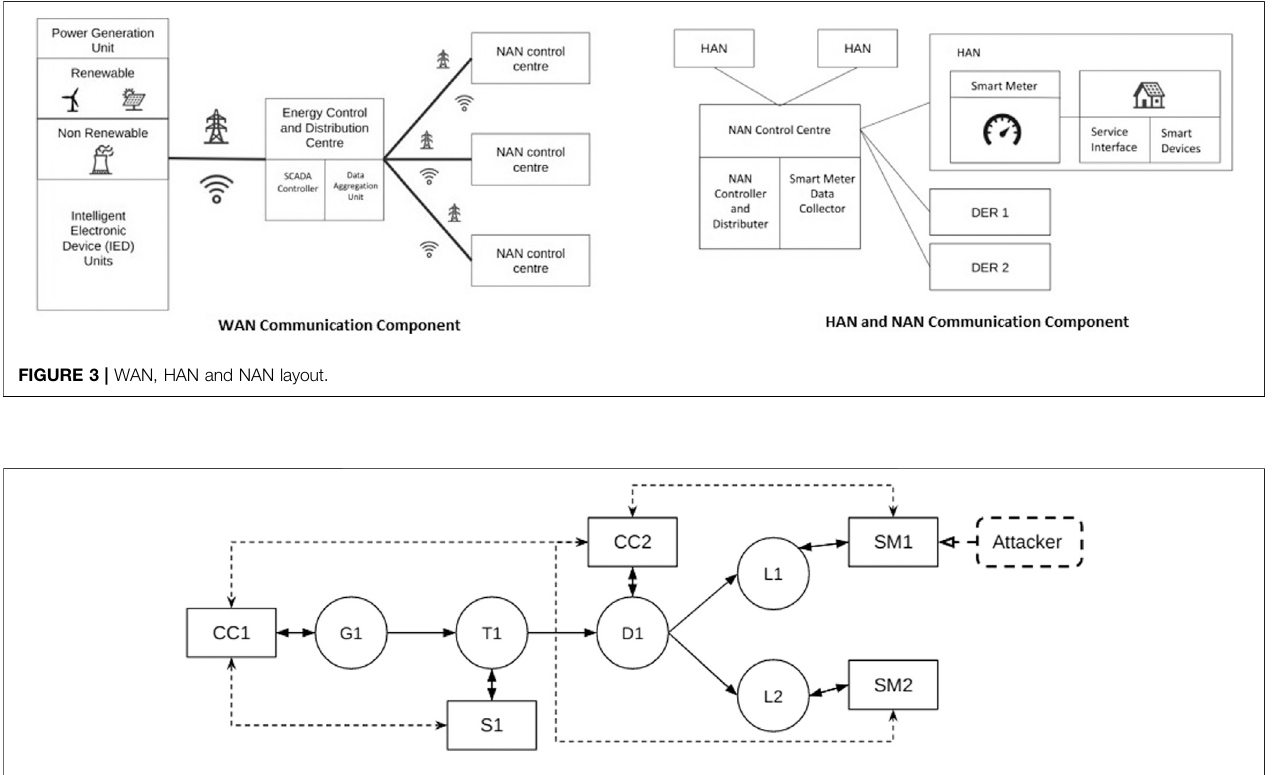
FIGURE 4 | Sample cyber-physical